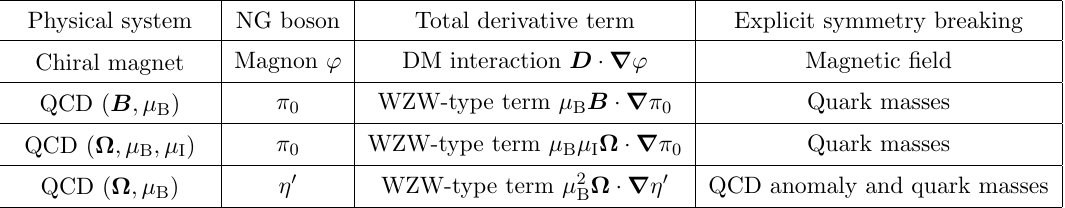
Table 1 . Examples of the CSL in chiral magnets and QCD